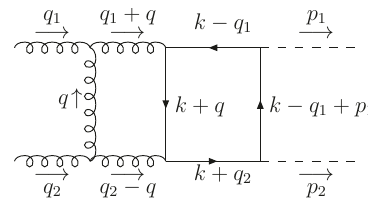
Figure 6 . Explicit de(cid:12)nitions of the virtual momenta in box